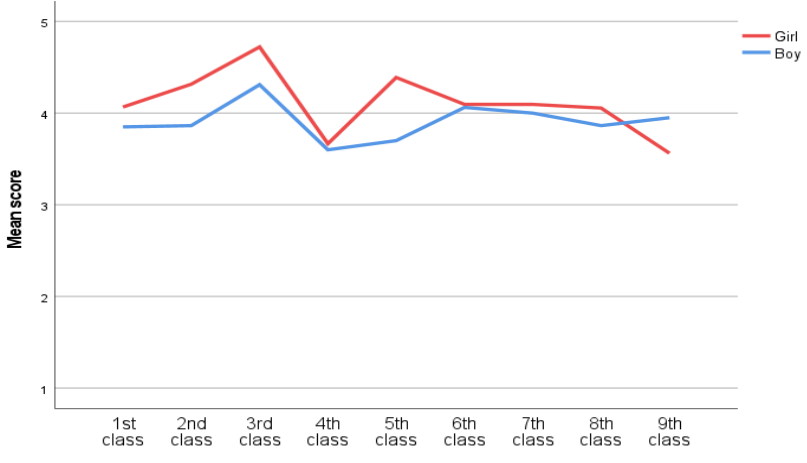
Figure 1. How are you feeling at school?